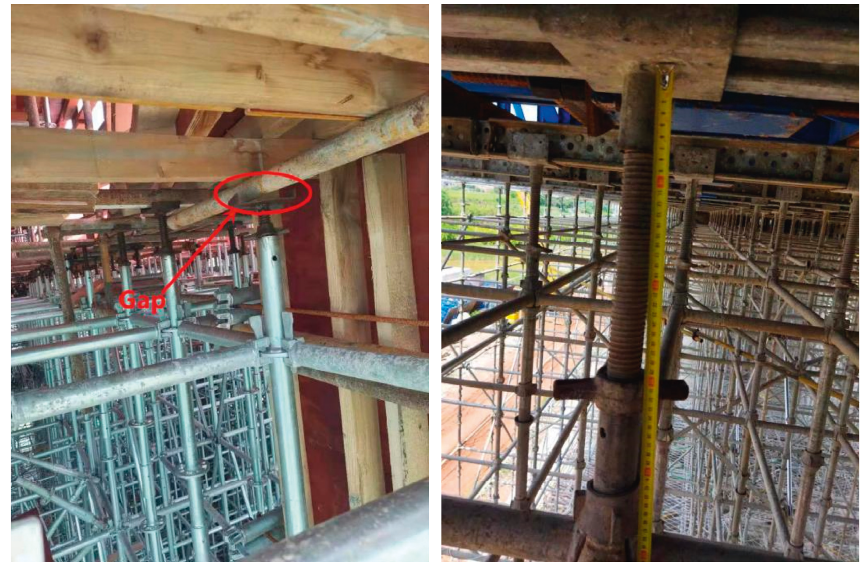
Figure 4: gaps between the adjustable support on the top of the vertical poles and bearer stringers.